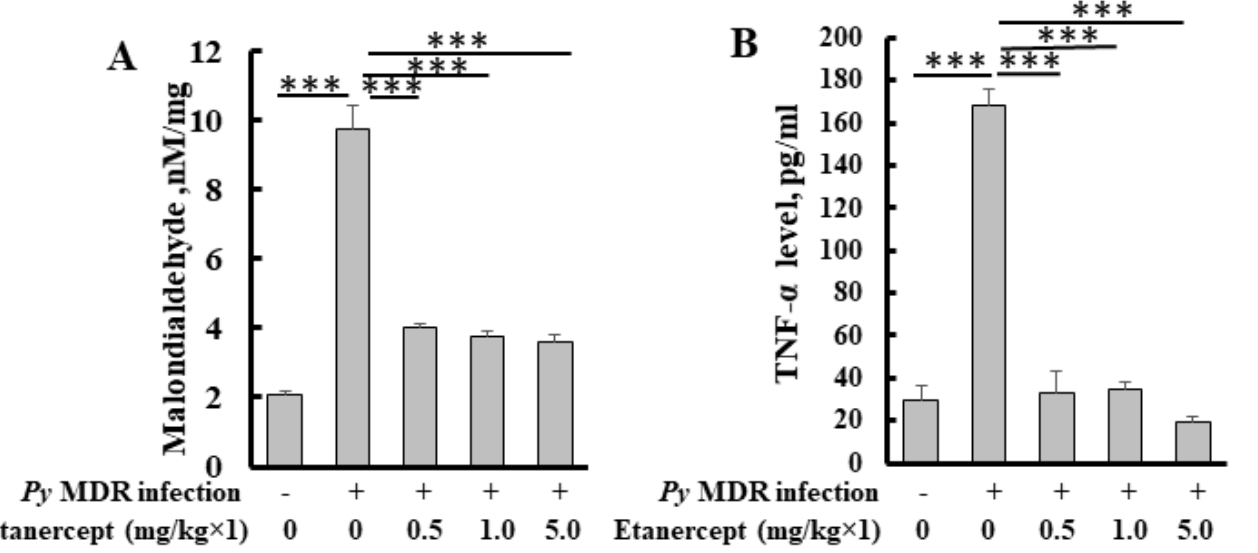
Figure 4. Quantification of MDA ( A ) and TNF- α ( B ) level in the livers of Etanercept treated mice. *** p < 0.0001.